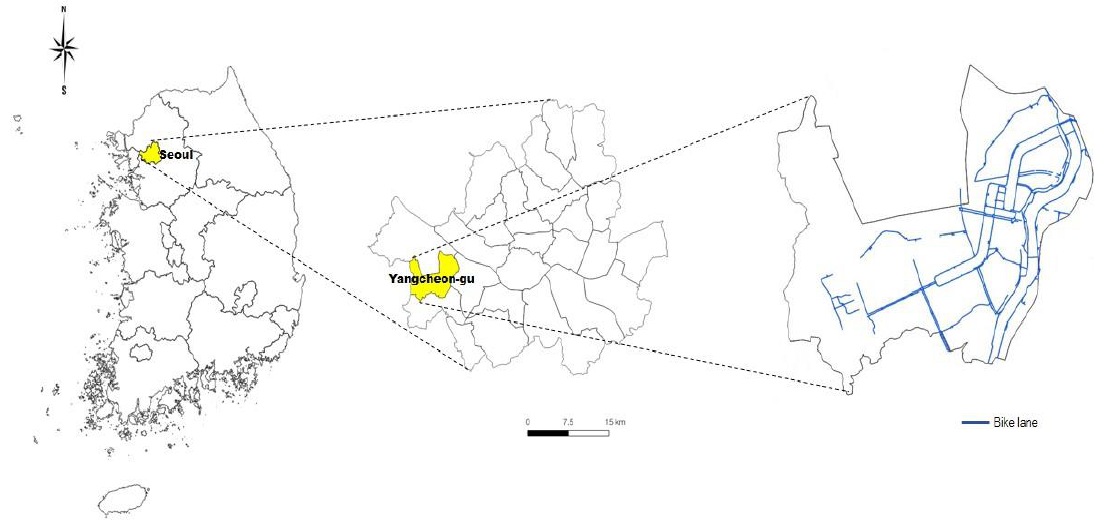
Figure 1. Yangcheon-gu in Seoul.